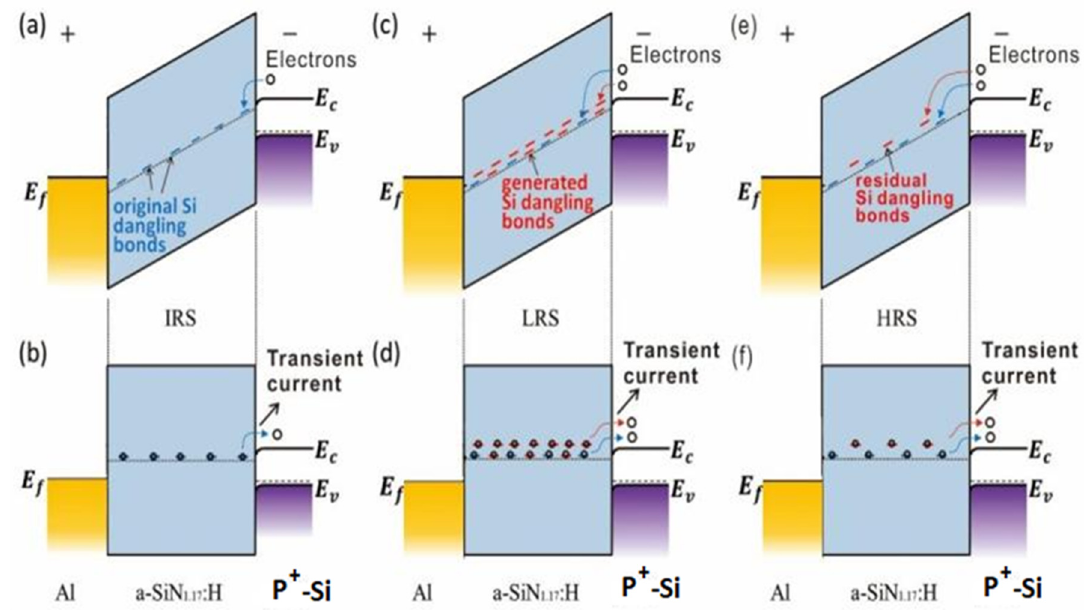
Figure 5. ( a – f ) The energy band diagrams of the Al/a-SiN 1.17 :H/P + - Si device in the IRS, LRS, and HRS during the charging and discharging process.